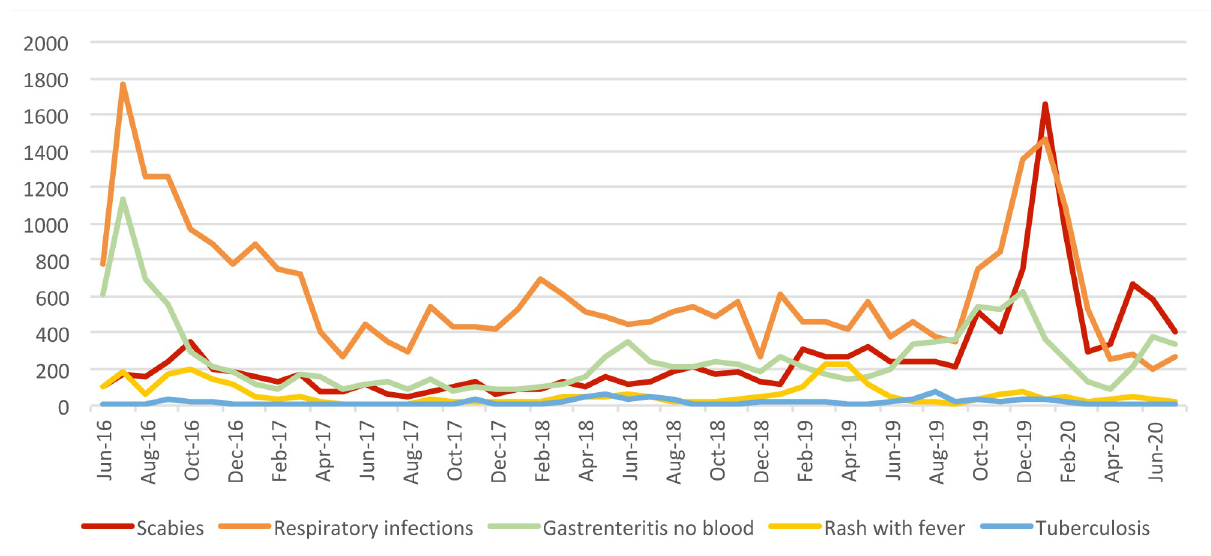
Fig 6. Number of consultations for clinical cases of scabies as compared to the four most common reported infectious diseases � , at the PoC, per month. � gastroenteritis without blood in the stool, respiratory infections, tuberculosis, rash with